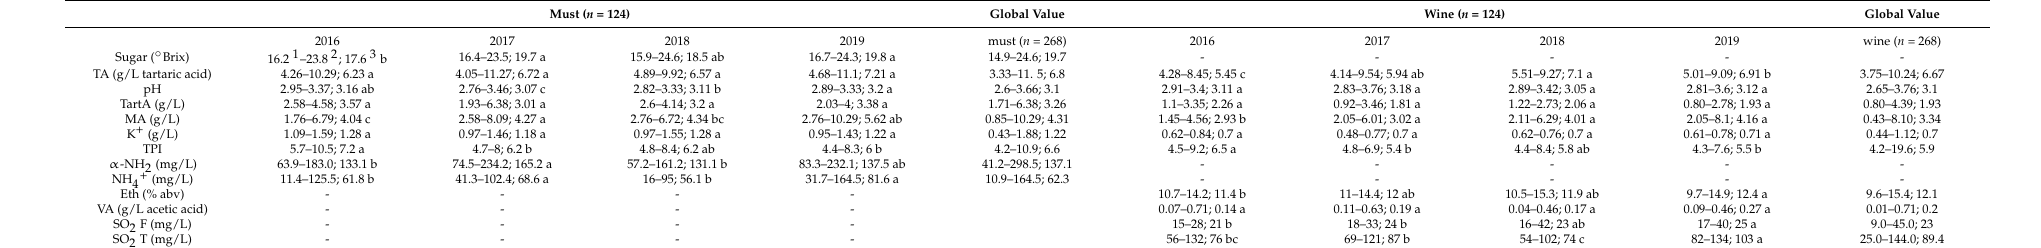
Table 2. Range and median values of oenological parameters.